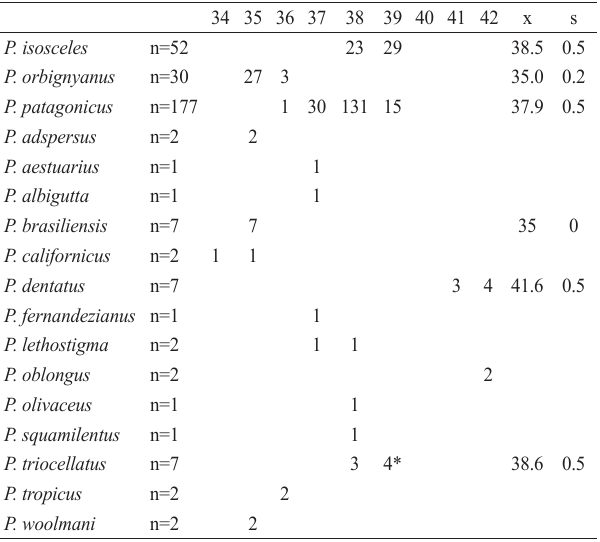
Tab. 3. Frequency comparison for counts of total vertebrae in species of Paralichthys . * include types.